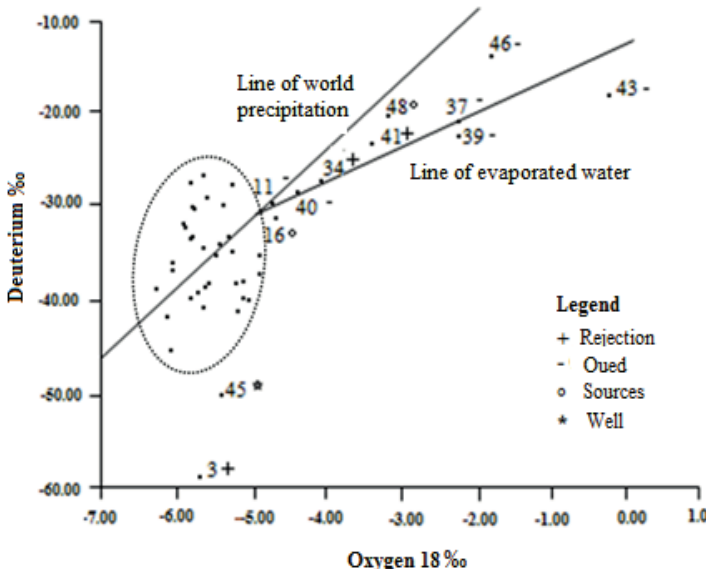
Fig. 4 The Deuterium–Oxygen 18